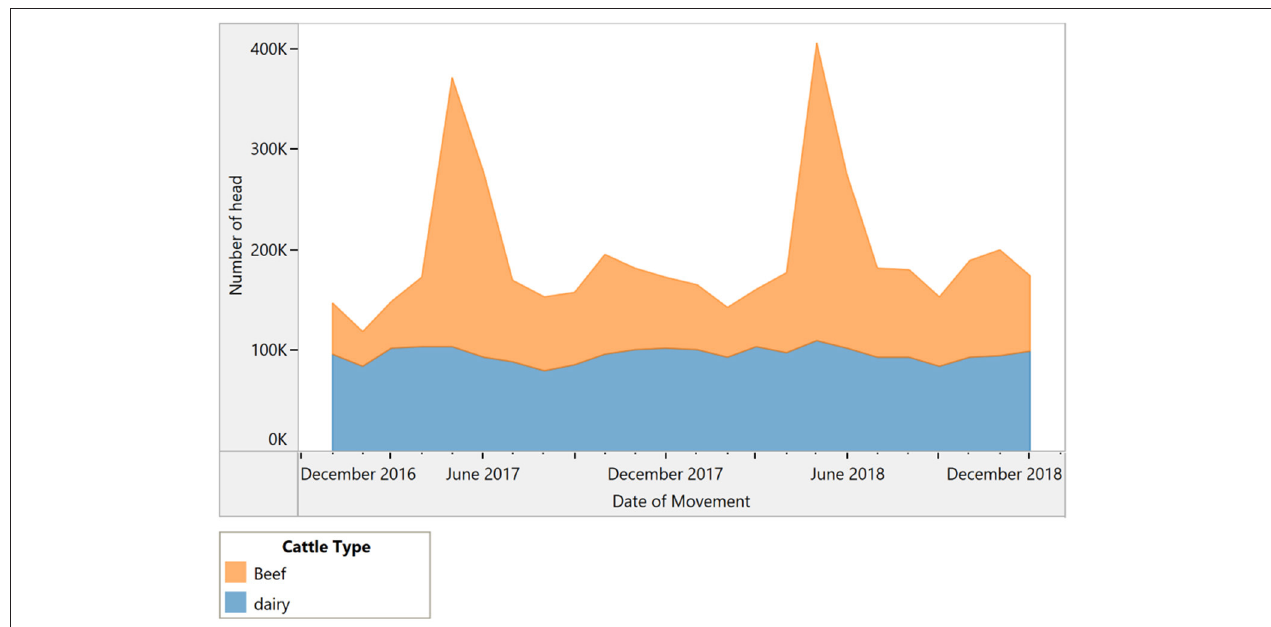
FIGURE 3 | Steers and heifers (number of head) moving from California grazing lands (beef) and dairies or feedyards (dairy) from January 2017 to December 2018.